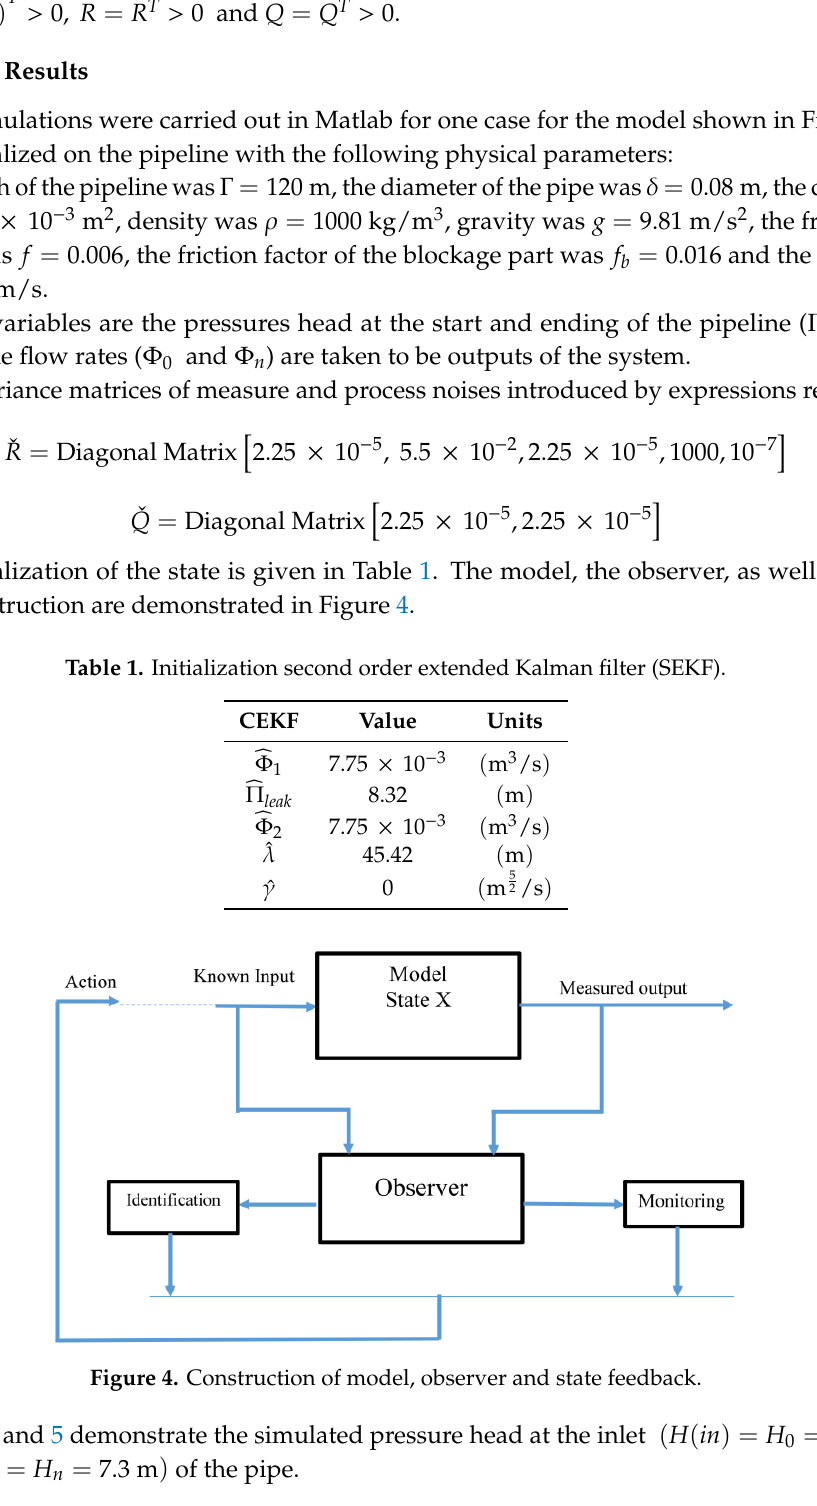
Figure 4. Construction of model, observer and state feedback.